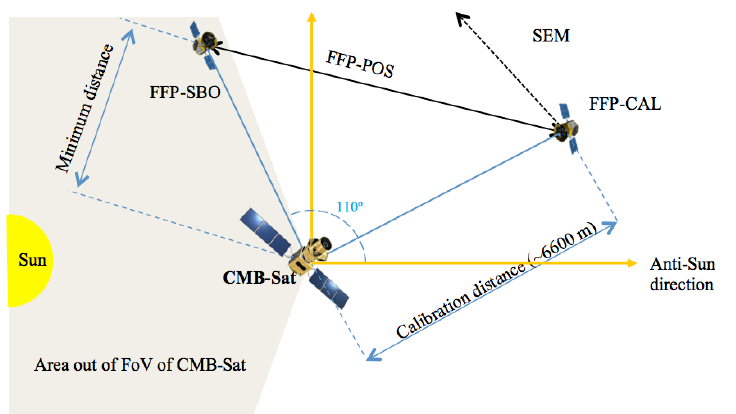
Figure 10. Diagram of the relative locations between the CMB satellite and L2-CalSat during the different phases of the